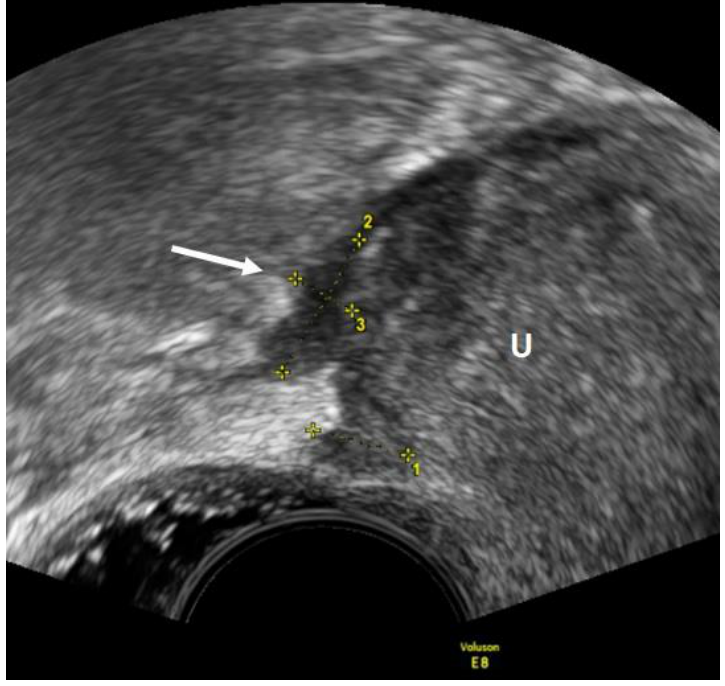
Figure 3. TVUS imaging method: USL lesion indicated by an arrow and calipers in the sagittal plane. U: uterus.